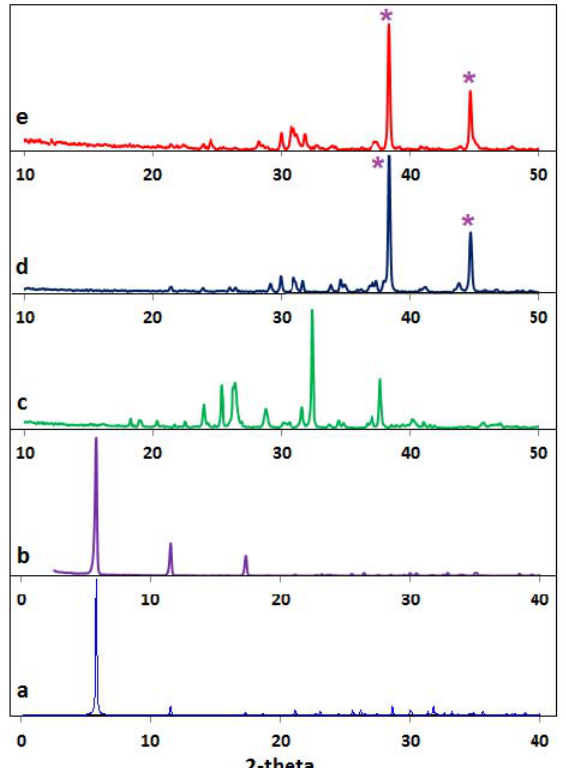
-T4S)] (1), b) crystals 5 n